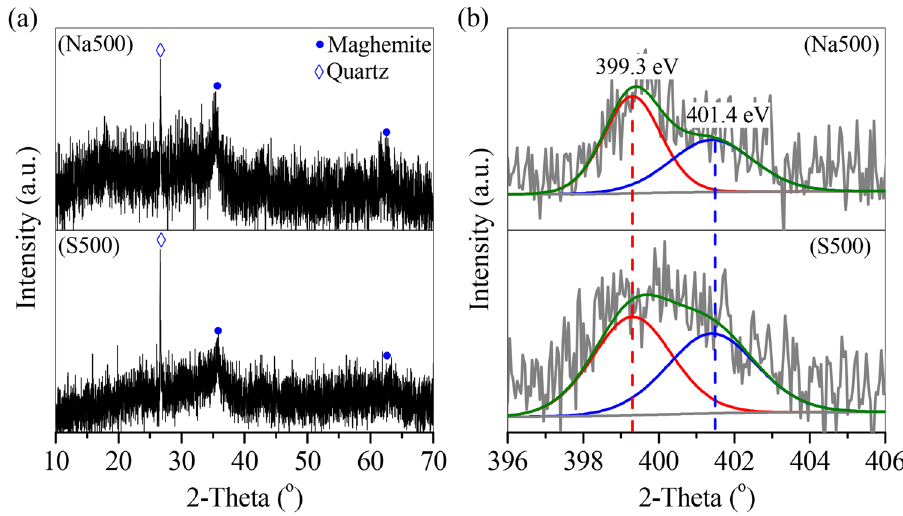
Figure 9. ( a ) XRD and ( b ) N1s XPS curves of Na500 and S500 after adsorption.